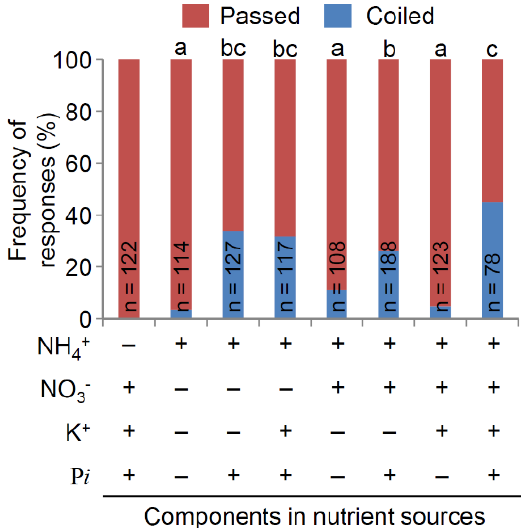
Figure 2. Nutritropic responses of the main root (passed or coiled) of WRC 25 to the components of the nutrient sources. The frequencies of passed and coiled responses were determined in the nutritropic bioassay with nutrient sources containing various nutrient combinations of NH 4+ , NO 3 − , K + , and/or P i at 200 mM. Statistical significance was tested using Fisher’s exact test with multiple testing corrections (Holm correction). Different letters on the bars indicate a significant difference at p < 0.05.